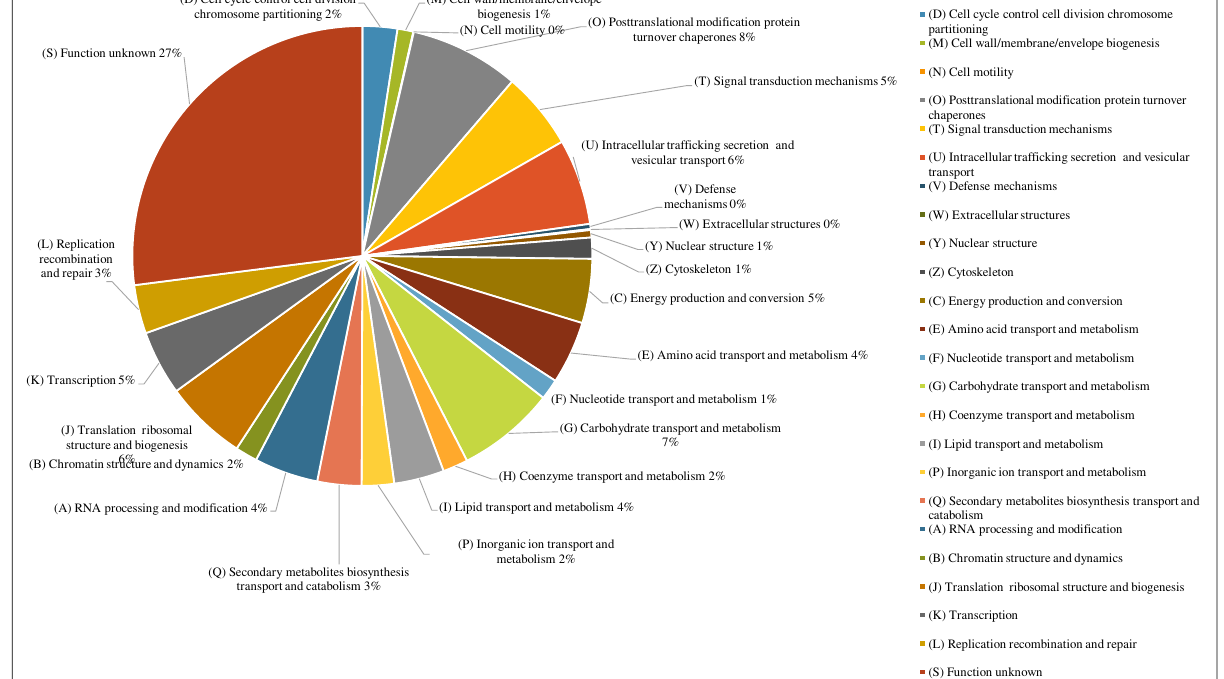
Fig. 7 Clusters of Orthologous Groups (COGs) of functional categories and their relative abundances in the Naganishia randhawae CBS 16859 genome (Huerta-Cepas et al. 2019)